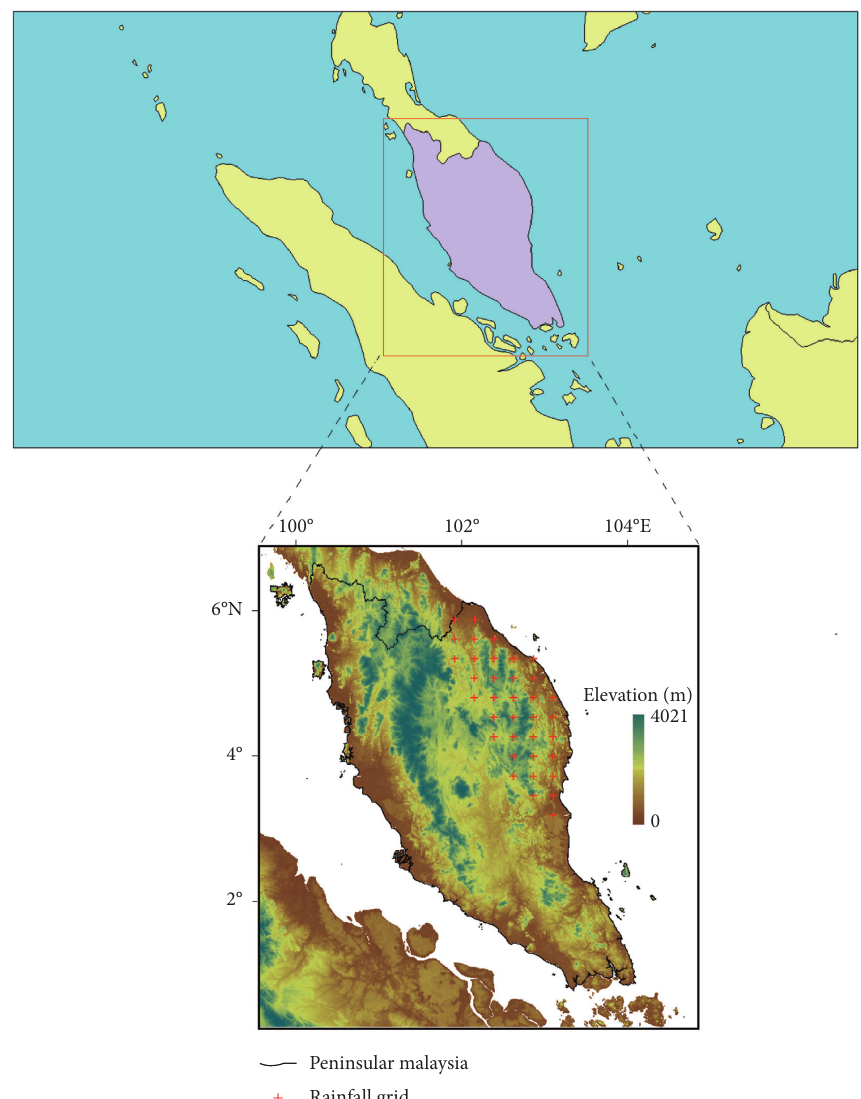
Figure 1: Location of Peninsular Malaysia in Southeast Asia. The elevation and location of grid points from where rainfall data were extracted.